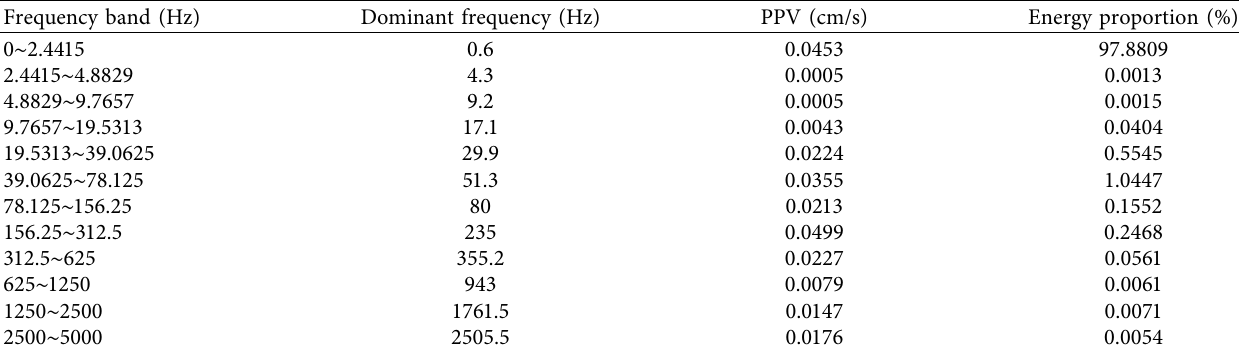
Table 6: Dominant frequency, PPV, and energy proportion of each subfrequency band at measuring point 71 in the far zone. Frequency band (Hz)